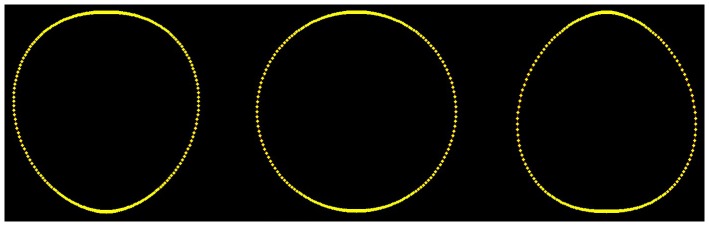
Path curves with different λ-values (left: 0.8, middle: 1.0, right: 1.3).This is the approximate range in which mistletoe berries change their shape.